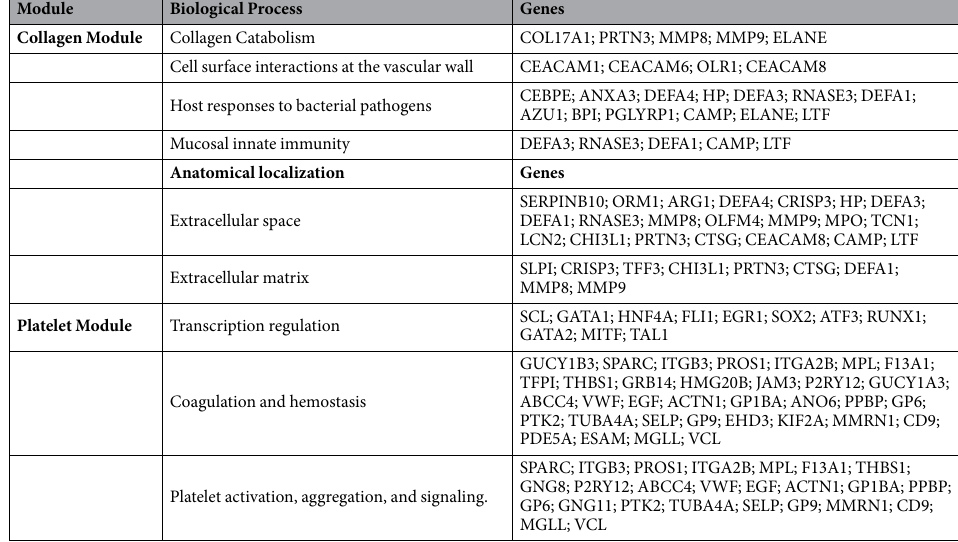
Table 5. Representative biological processes and anatomic localizations within the two gene coexpression